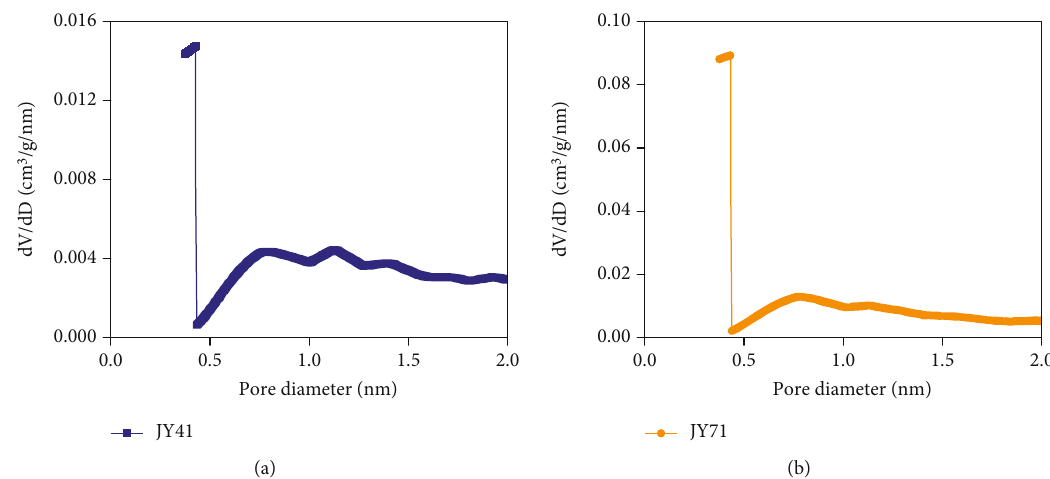
Figure 5: Micropore size distribution of selected gas shales derived from nitrogen adsorption isotherms using the H-K method.